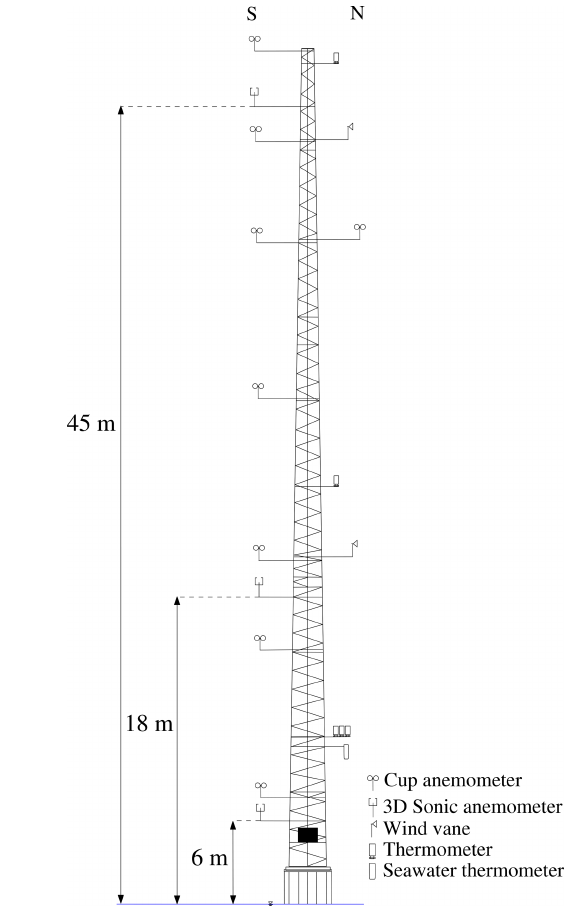
Figure 3. Sketch of the atmospheric instrumentation at SMW. The sonic anemometers are located in the southern boom “S” oriented at 226 ◦ from the